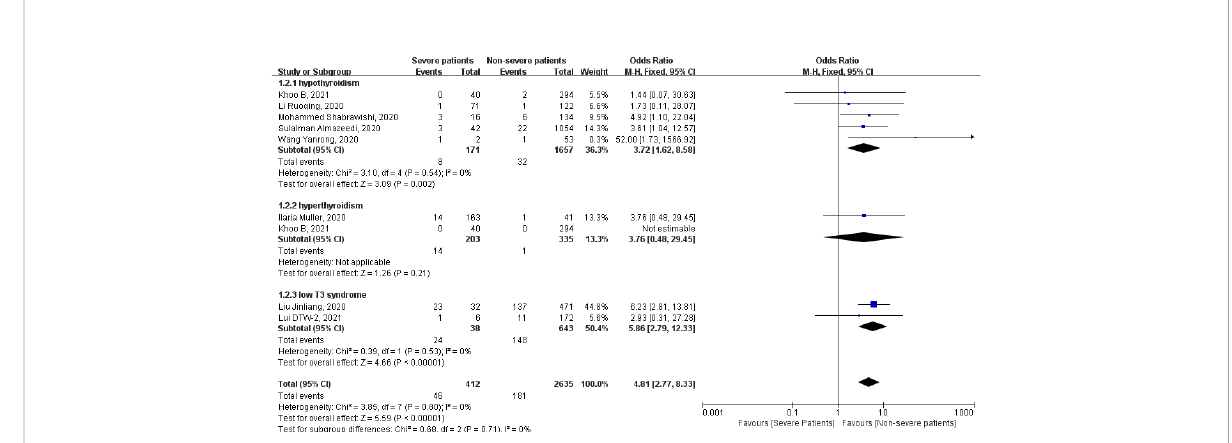
FIGURE 4 Forest plot of the association of the severity of coronavirus disease 2019 (COVID-19) infection with hypothyroidism, hyperthyroidism, and low T3